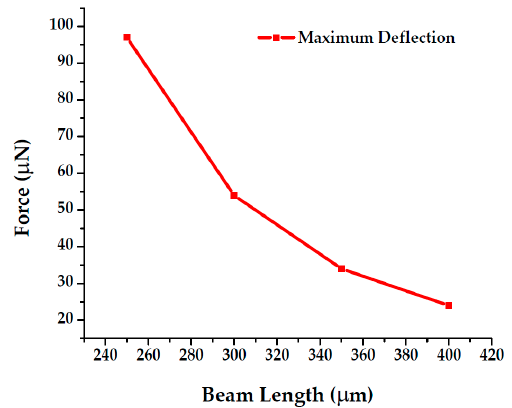
Figure 18. Relation between force and beam length for constant displacement.